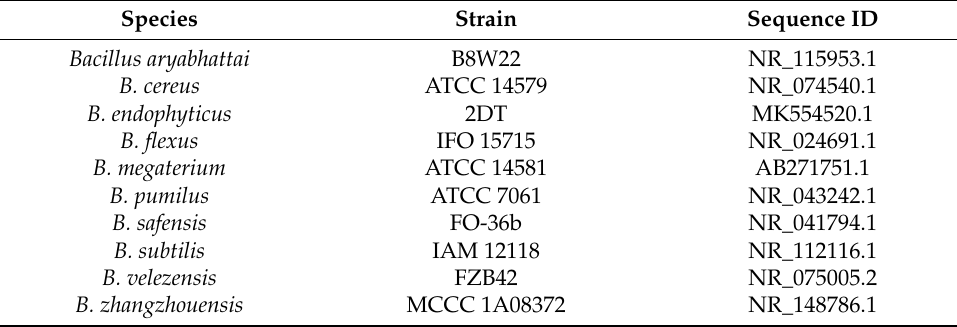
Table 2. Bacillus species used in the 16S rRNA sequence